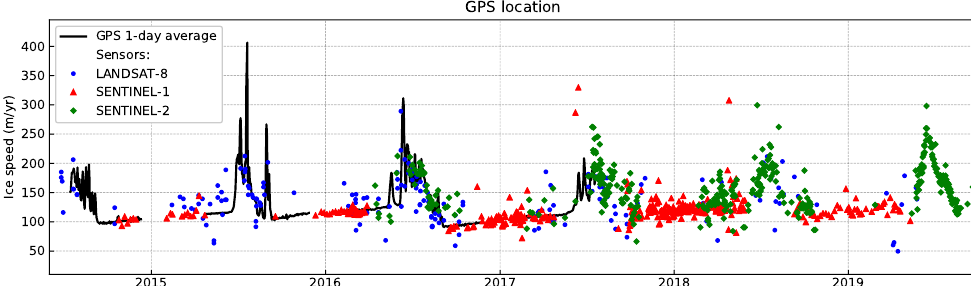
Figure 5. Ice velocity measurements from in-situ GPS station (black line) [33] and from satellite systems (colored dots) derived by us for location 67.182 ◦ N, 49.56 ◦ W as indicated by red dot at Figure 1. The color-coding for sensors is the same as in Figure